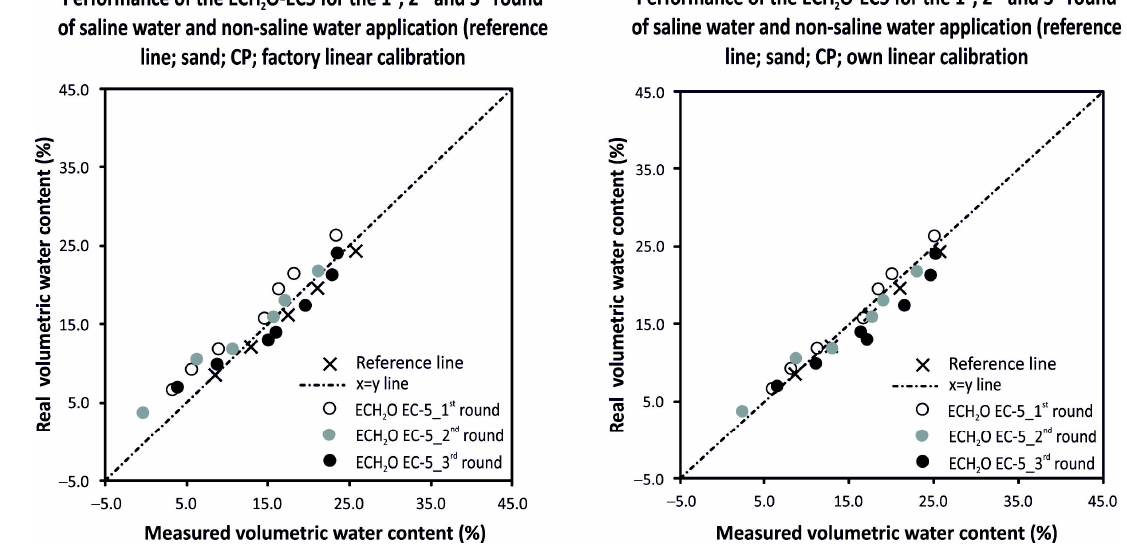
Figure 6. Real and measured volumetric water contents determined by ECH 2 O EC-5 for all three rounds of the drying/wetting cycle with saline water application with an indication of a reference line that was based on non-saline water application.